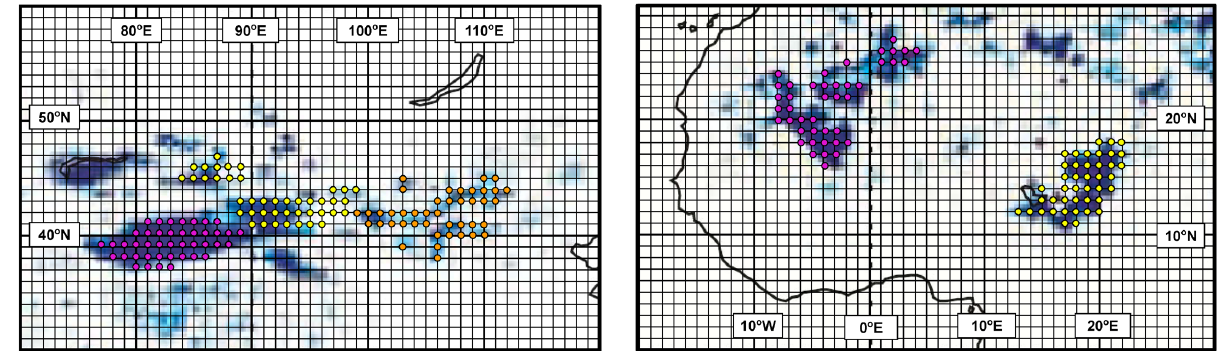
Fig. 1. Circles show the locations of Asian (left) and African (right) trajectory starting points (42 per region) used in this study, superim- posed on a map (adapted from Tegen, 2003) of preferential dust source areas (in blue) derived from potential past lake areas. Pink points represent the Asian Taklimakan desert and West African dust sources, yellow points represent the western Gobi desert in Asia and the Bod´el´e Depression in Africa, while orange points represent the eastern Gobi